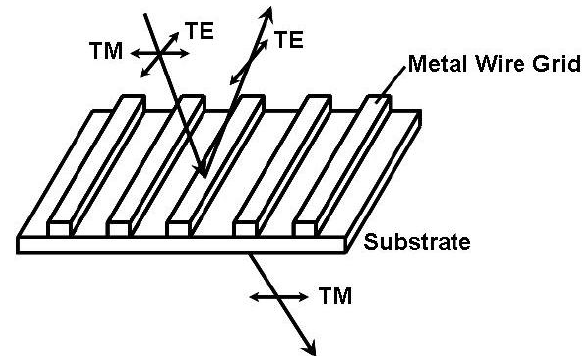
Figure 1. The working principle of a wire grid polarizer.